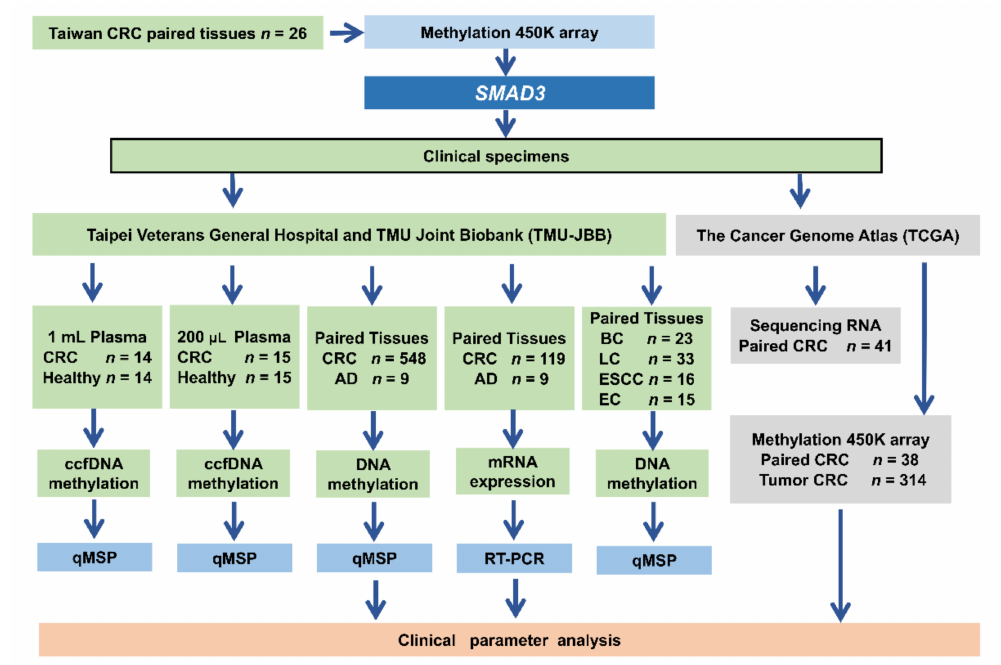
Figure 9. Flowchart of the study design, datasets and specimens used. For each step, the sample types and number of samples used for the analyses are indicated. CRC, colorectal cancer; AD, benign adenoma; BC, breast cancer; LC, lung cancer; ESCC, esophageal cancer; ES, endometrial cancer; ccfDNA, circulating cell-free DNA; QMSP, quantitative methylation-specific PCR; qRT-PCR, quantitative reverse-transcription PCR; methylation 450K array, Illumina Infinium HumanMethylation450 BeadChip